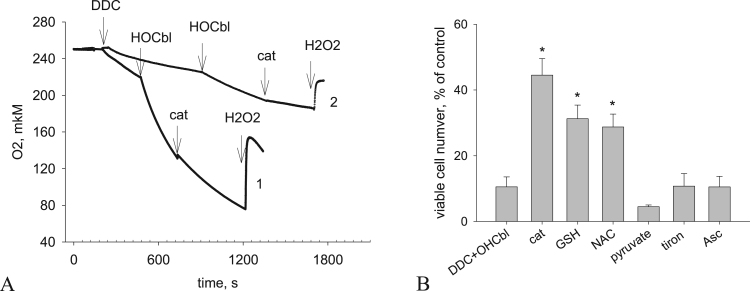
Oxidative stress induced by the combined action of DDC and HOCbl. (A). HOCbl (25 μM) catalyzes the reduction of oxygen by DDC. Oxygen concentration was measured after the addition of DDC and HOCbl to PBS in a chamber at 20 °C using an O2 electrode. Curve 1: 10 mM DDC, 250 μM HOCbl, 500 U catalase, 150 μM H2O2. Сurve 2: 1 mM DDC, 25 μM HOCbl, 100 U catalase, 50 μM H2O2. (В). Antioxidants partially inhibit the cytotoxic effect induced by DDC + HOCbl in А549 cells. Antioxidants were added to the cells 24 h after the seeding in 96-well plates, 1 h prior to, or simultaneously with the addition of 1 mM DDC + 25 μM HOCbl. The action of DDC + HOCbl was interrupted by replacing the culture medium with a fresh growth medium. The cytotoxicity was estimated at 48 h after the addition of the components (see Materials and methods). The data are the means ± SEM of five separate experiments. * P < 0.01, compared to cells treated with DDC + HOCbl.